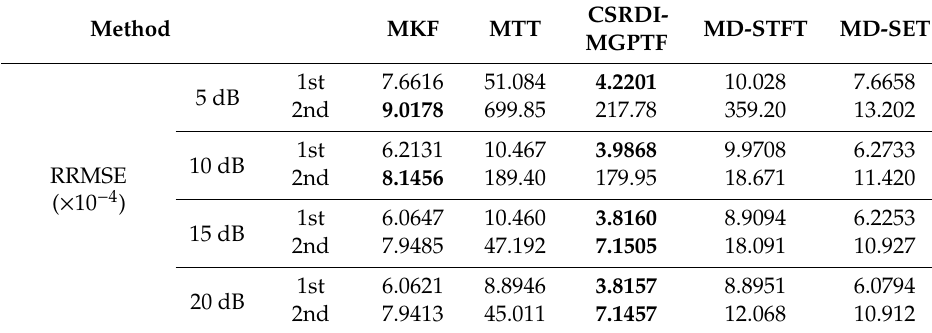
Figure 9. TF spectrums and IF estimation results for example 3 with SNR = 5 dB. ( a ) TF representation acquired by STFT; ( b ) TF representation acquired by SET. ( c ) MKF; ( d ) MTT; ( e ) CSRDI-MGPTF; ( f ) MD-STFT; ( g ) MD-SET. Table 4. Performance evaluation of IF Estimation for example